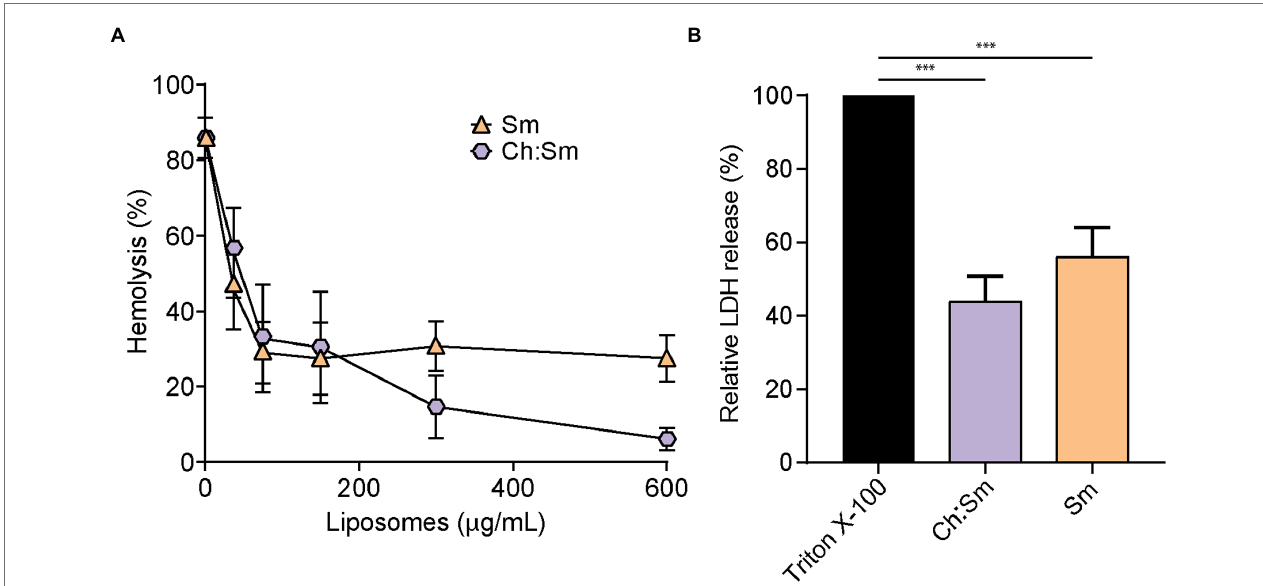
FIGURE 1 | Engineered liposomes reduced the lysis of human cells induced by Pseudomonas aeruginosa bacterial supernatant grown in modified cystic fibrosis medium. (A) Human red blood cells were incubated with LESB58 (100 μ l) bacterial supernatant and cholesterol-containing (Ch:Sm) or sphingomyelin only (Sm) liposomes for 1 h ( n = 11, each treatment). (B) 16HBE14o- cells after challenge with Pseudomonas aeruginosa LESB58 stationary-grown supernatants (100 μ l), normalized to Triton X-100. Both types of liposomes (300 μ g/ml) decreased the release of lactate dehydrogenase ( n = 17). Error bars, mean ± standard error. A one- way ANOVA with post-hoc Dunn’s multiple comparison test was performed between treated and non-treated exposure, value of p (*** < 0.001) adjusted for multiple